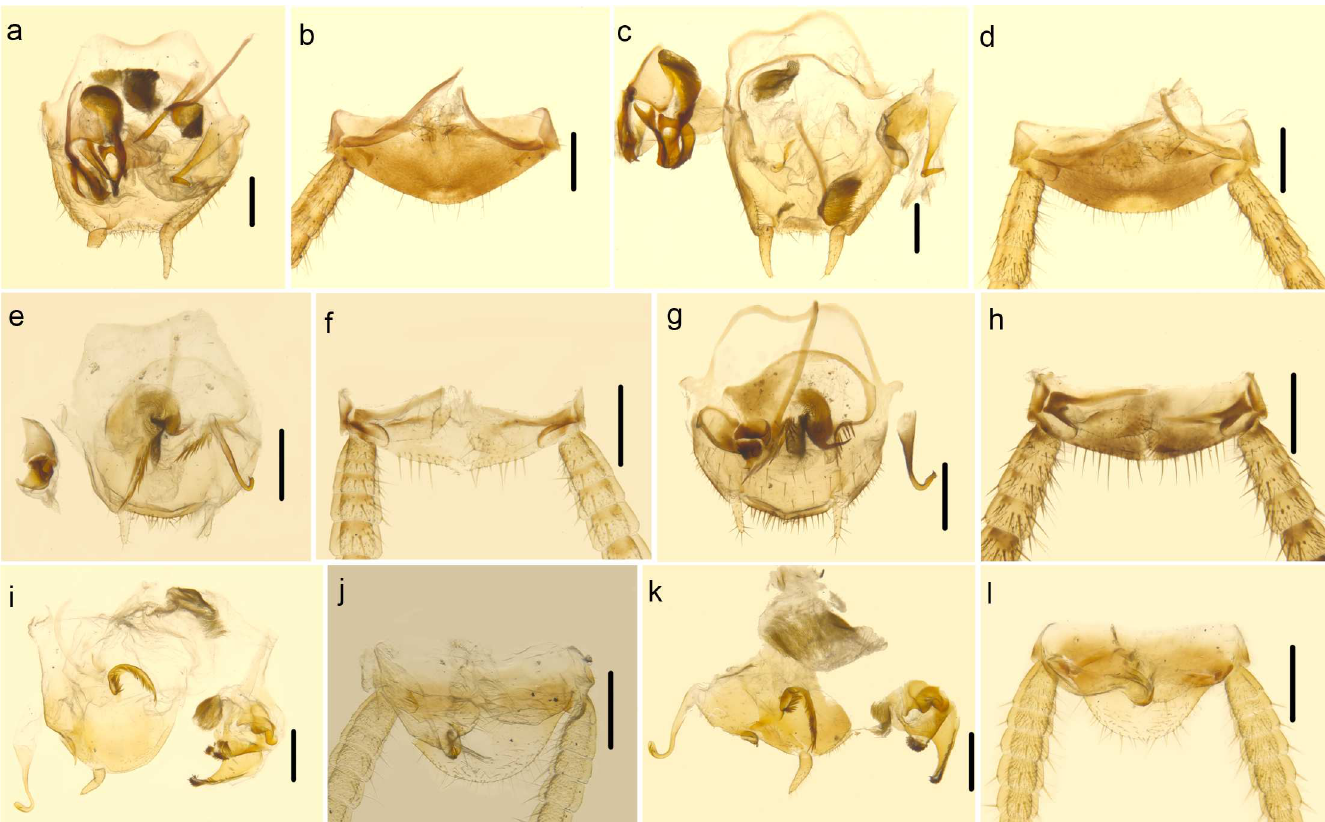
Fig 3. Phylogenetic chronogram of ectobiid species based on COI gene with 2 mantid outgroups, reconstructed using BEAST. An optimal partitioningscheme was determined by PartitionFinder. Scale bar estimates age in millionsof years and blue bars represent 95% highest posterior density intervals for the node